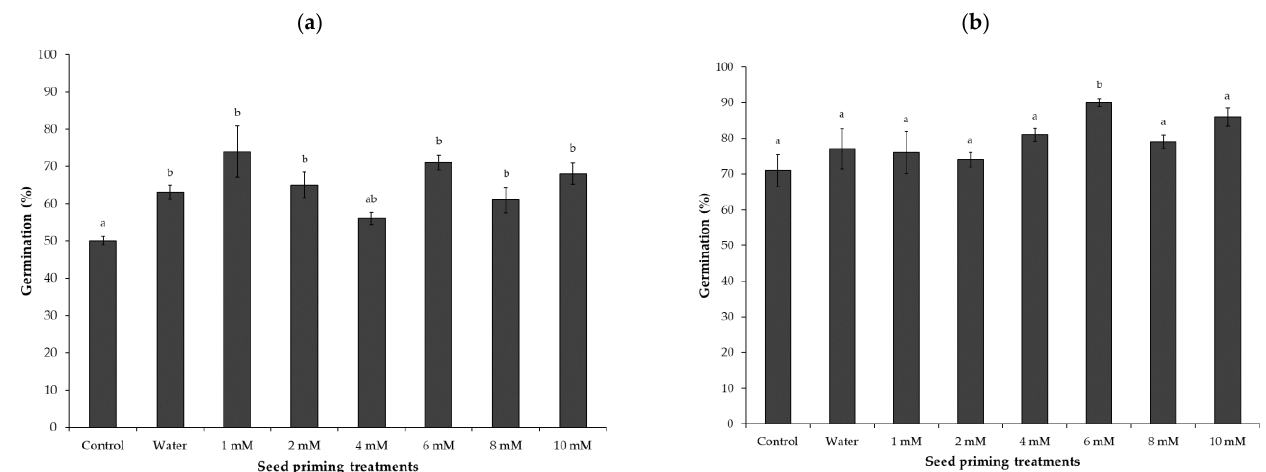
Figure 1. Germination percentage (%) of spinach seeds at Day 7 ( a ) and Day 14 ( b ) after sowing on top of paper in Petri dishes at 15 °C. Seed priming treatments included control (unprimed), water- primed, and Zn-primed at various Zn concentrations (1, 2, 4, 6, 8, and 10 mM Zn) in the priming solution. Bars represent the mean and standard error (SE) of four replicates (25 seeds in each replicate). Significant differences between the means were calculated at p < 0.05 and marked with different